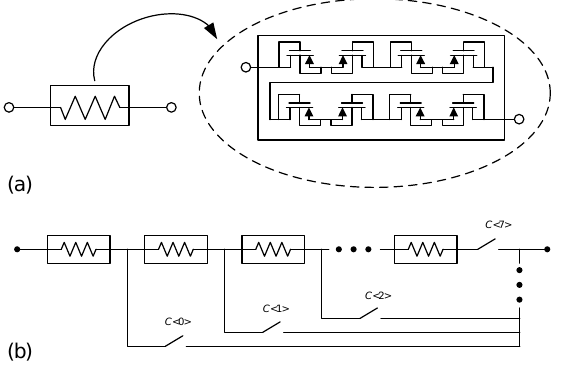
Figure 12. Feedback pseudoresistor implementation: ( a ) unit element; ( b ) programmable